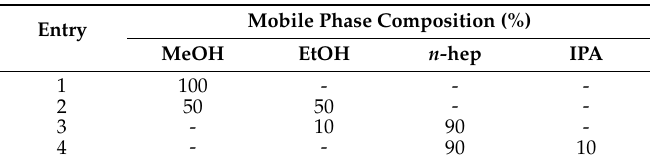
Table 2. Screening protocol: mobile phase composition.